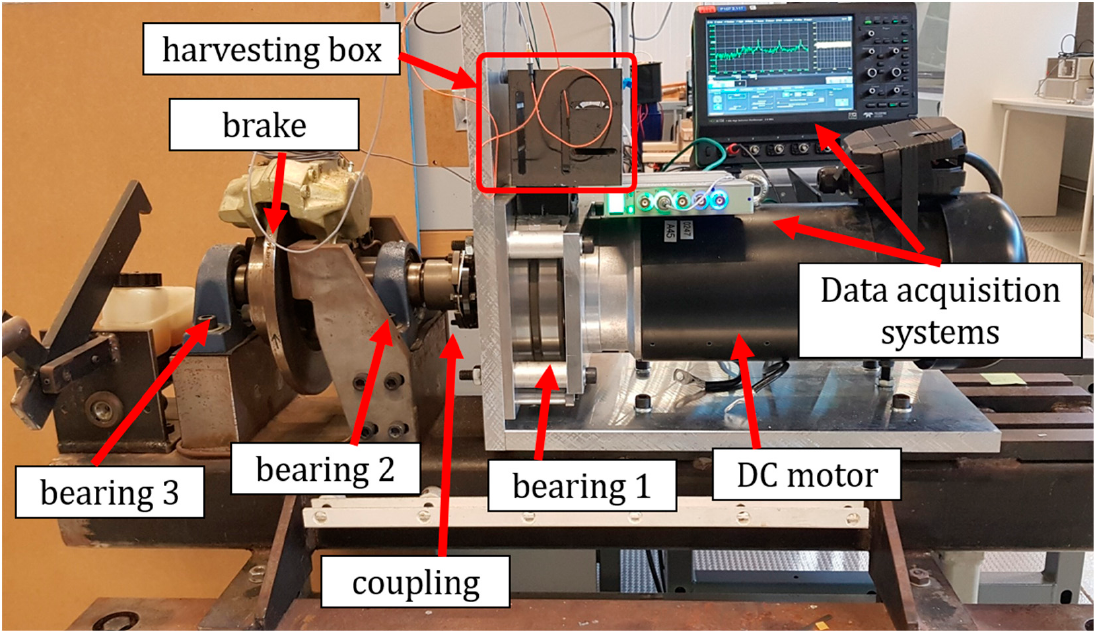
Figure 7. Experimental setup, the DC motor with an energy harvesting box attached to the main bearing, with data recording systems.